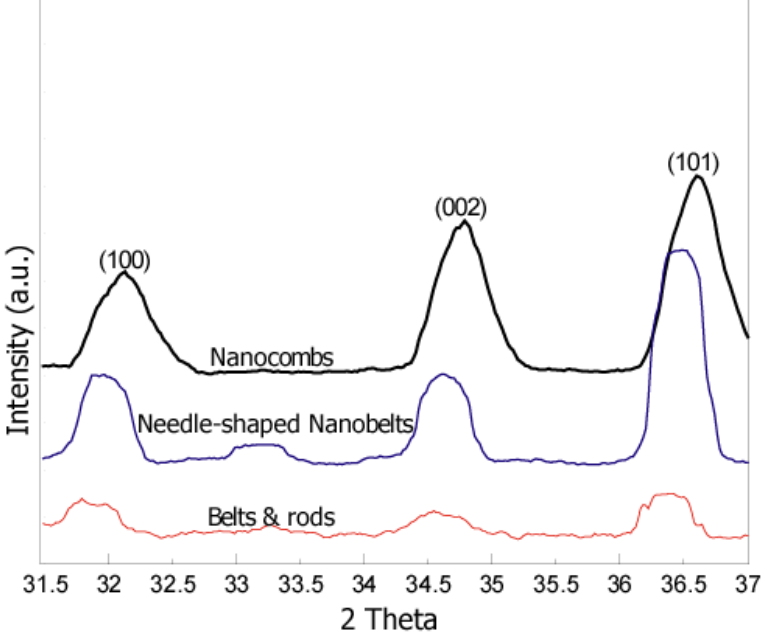
Figure 2. XRD results of as-synthesized ZnO nanostructures. Continuous shift in the peak towards higher angle and narrower FWHM suggests better crystalinity.